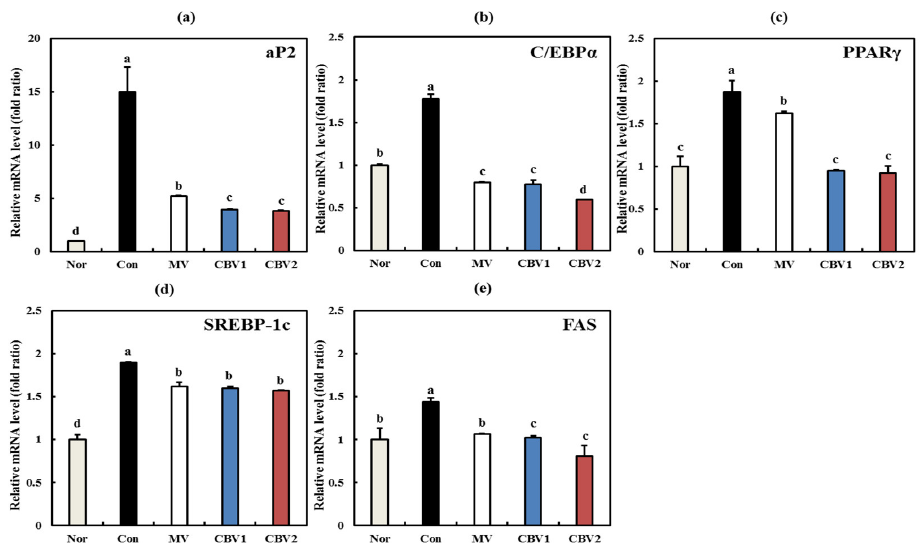
Figure 4. Anti-obesity related gene expression of CBVs in 3T3-L1 cells. ( a ) aP2 mRNA level; ( b )